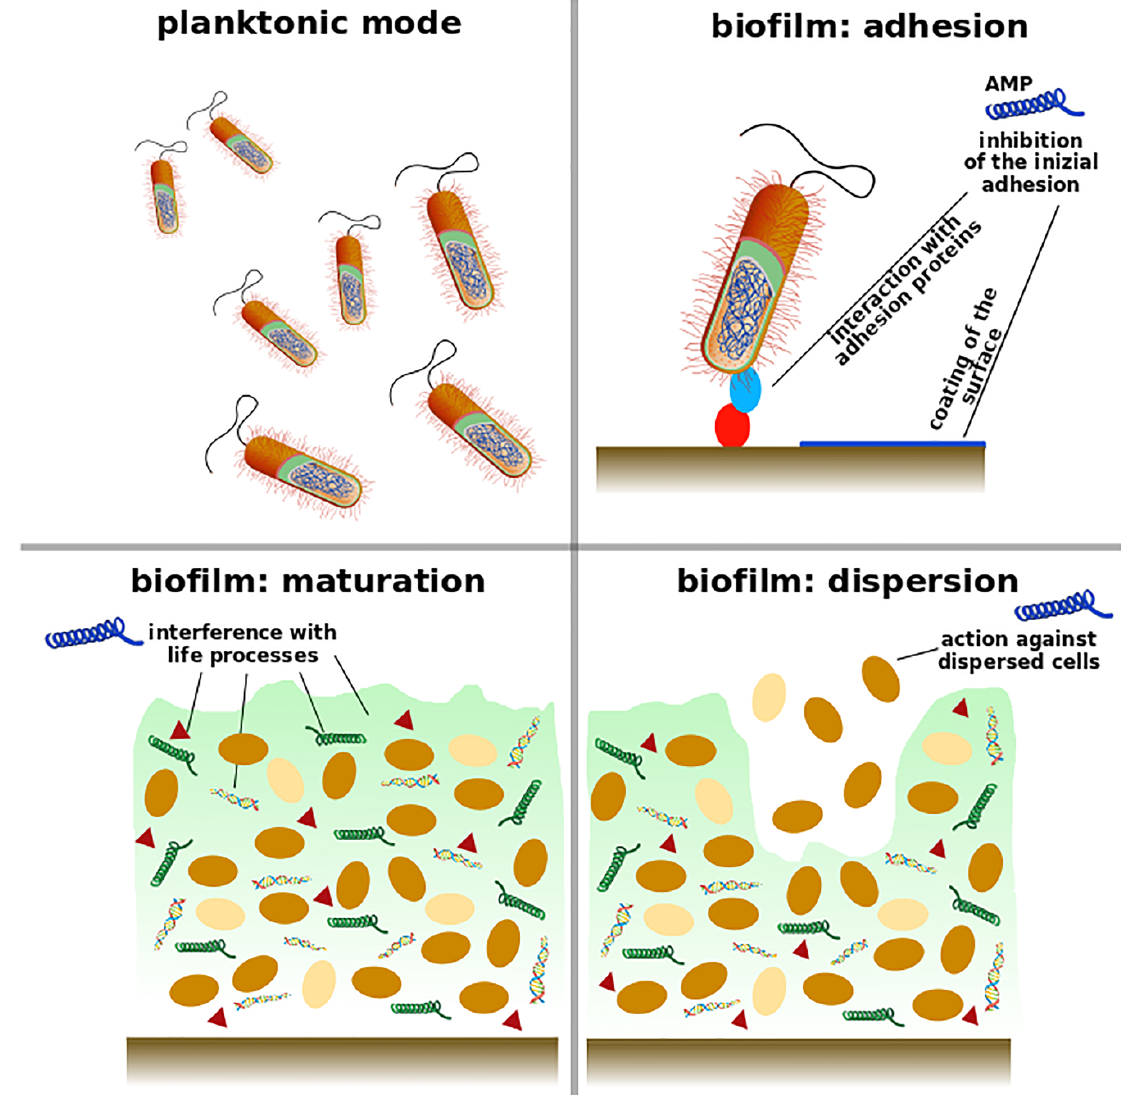
Figure 1. Biofilms develop in three phases: initial adhesion, maturation, and dispersion. A good anti-biofilm agent (blue peptide) can be involved in all the biofilm phases. AMPs may inhibit the accumulation of bacteria on the surface by interacting with their adhesion proteins (red and light blue) or coating the surface to protect from bacterial attack. Antimicrobial peptides can display an action against bacteria in their active state in the biofilm (brown); they can also defeat bacteria in the persisters models (yellow) or interfere with life processes such as synthesis of EPS (light green matrix), signaling compounds (triangle), extracellular DNA, and proteins (green helix).